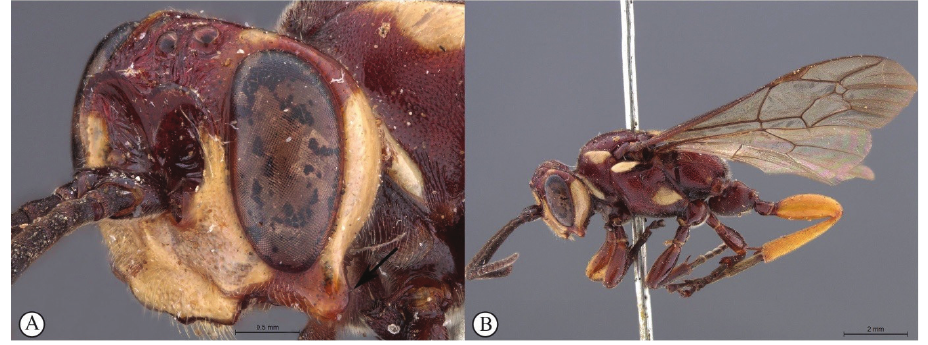
9 Lower gena expanded into a backward curved, bluntly triangular, protuber- ance (A); wings hyaline (B) ................................. G. varianum (Tosquinet)